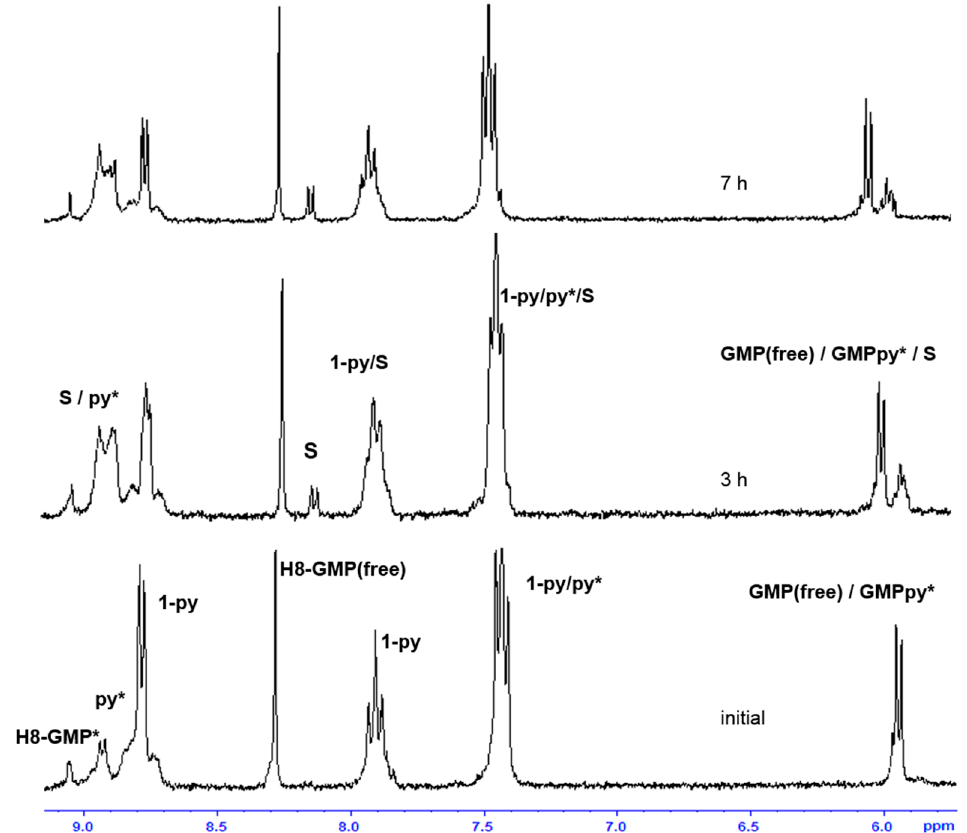
Figure 3. Progress of the reaction between complex 1 and 5 ′‐ GMP at 37 °C monitored by 1 H NMR (acetone ‐ d 6 and D 2 O in a ratio 2:1) showing changes in the aromatic area. Labels: GMP(free), free 5 ′‐ GMP; H8 ‐ GMP*: H8 ‐ 5 ′‐ GMP coordinated adduct signal; 1 ‐ py, pyridine ligand signals of complex 1 ; py*, adduct pyridine signal, and S: speciation.